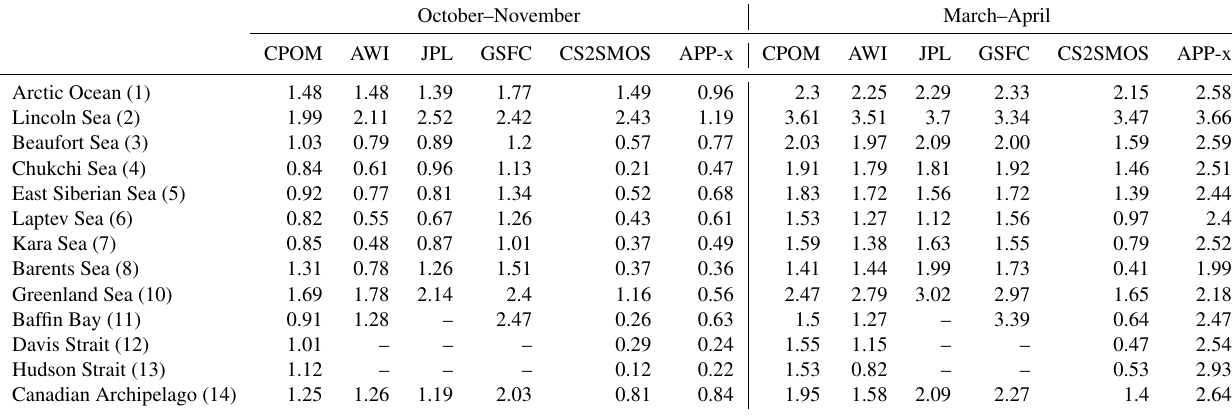
Table 2. Seasonally averaged sea ice thickness for each Arctic region (in m) for all six data products. Regional thickness is reported for all regions that contain valid thickness estimates, and there were no valid observations for region (9), the Norwegian Sea. The data used in this table span the period 2010–2018, based on product availability, as outlined in Table 1. Average thicknesses are calculated only based on years in which ice is present.